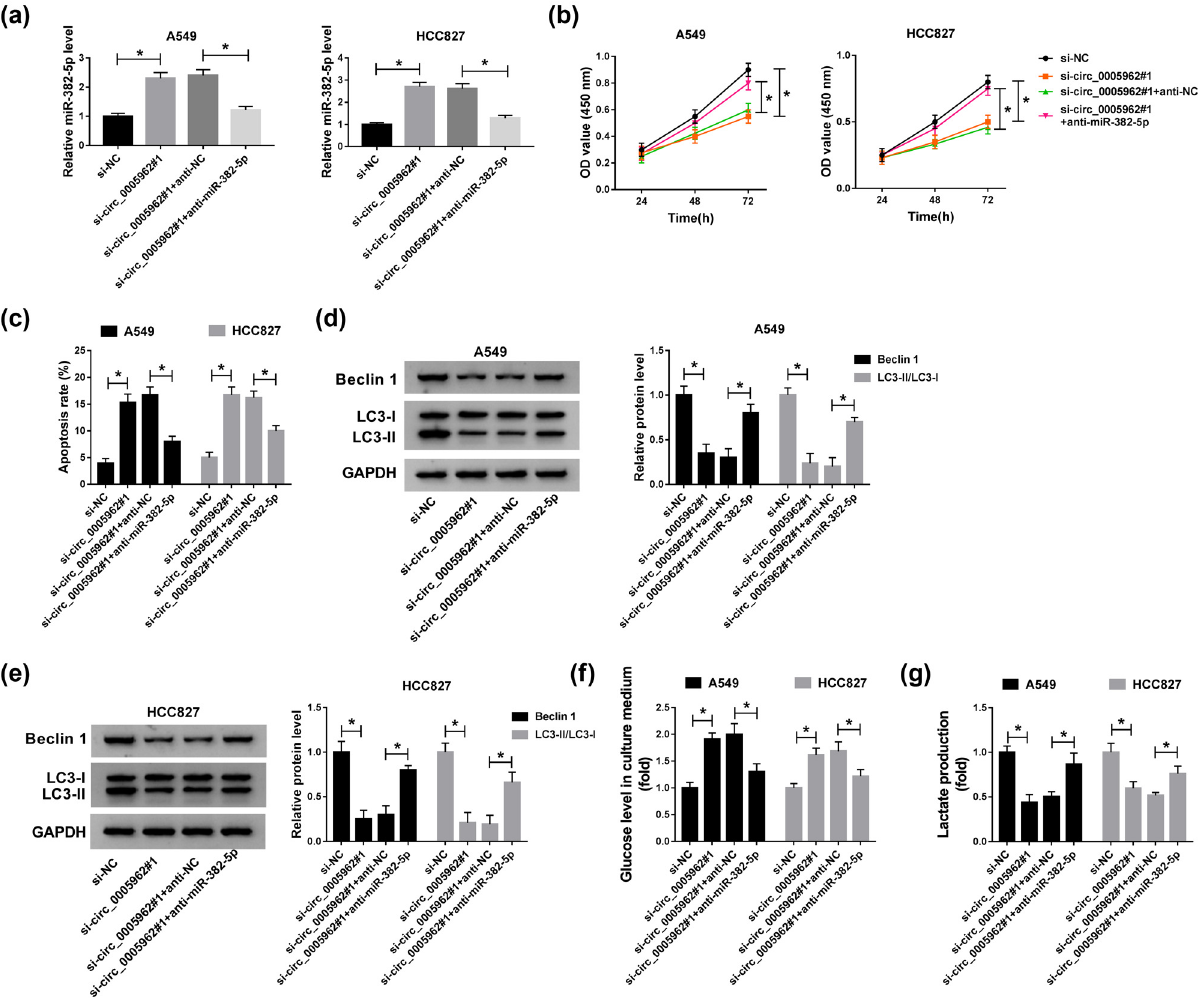
Figure 4: Inhibition of miR - 382 - 5p reversed the role of circ_0005962 knockdown. A549 and HCC827 cells were introduced with si - circ_0005962#1, si - NC, si - circ_0005962#1 + anti - miR - 382 - 5p or si - circ_0005962#1 + anti - NC. ( a ) The transfection e ffi ciency was examined by qPCR. ( b ) Cell proliferation was assessed by CCK - 8 assay. ( c ) Cell apoptosis was executed by fl ow cytometry assay. ( d and e ) The protein levels of Beclin 1 and LC3 - II/LC3 - I were quanti fi ed by western blot. ( f and g ) The glycolysis progression was evaluated according to the levels of glucose in culture medium and lactate production. * P <